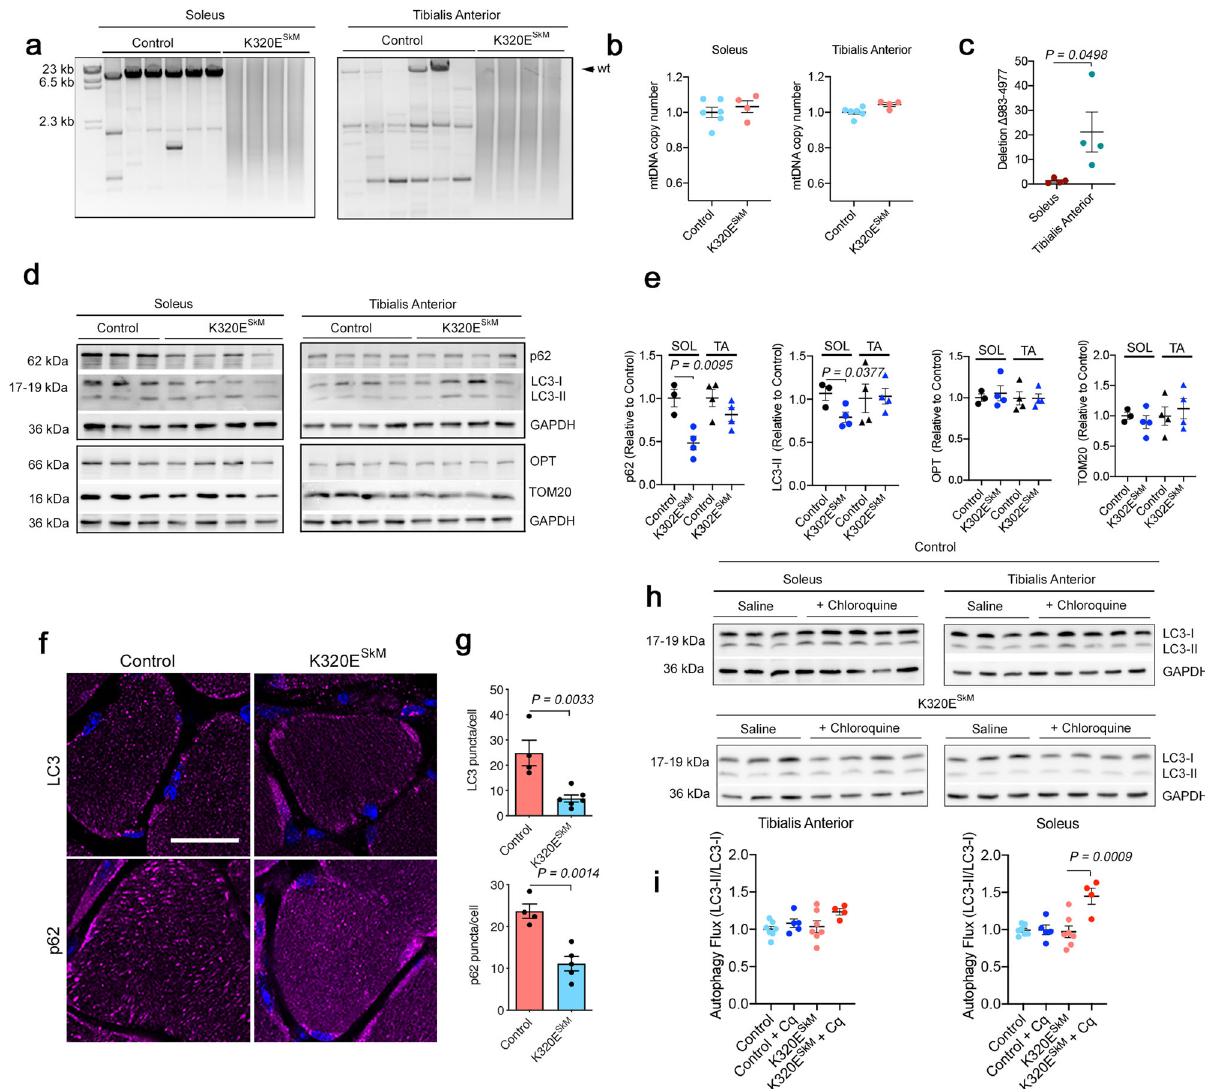
Fig. 1 | In vivo expression of Twinkle-K320E induces differential accumulation of mtDNA alterations. a Long range PCR analysis and b quantitation of mtDNA copy number in M. soleus and M. Tibialis anterior from 24 months old control and Twinkle-K320E SkM mice (control: n =6; K320E: n =4). c qPCR quantitation of dele- tion mtDNA- Δ 983-4977 in M. soleus and M. Tibialis anterior from 2 years old mice ( n =4). d , e Western blot analysis and quanti fi cation of the indicated proteins in muscle extracts from these mice. (Soleus, control: n =3; Twinkle-K320E: n =4. M. TA,control: n =4;Twinkle-K320E: n =4). f , g Insituimmuno fl uorescenceandimage